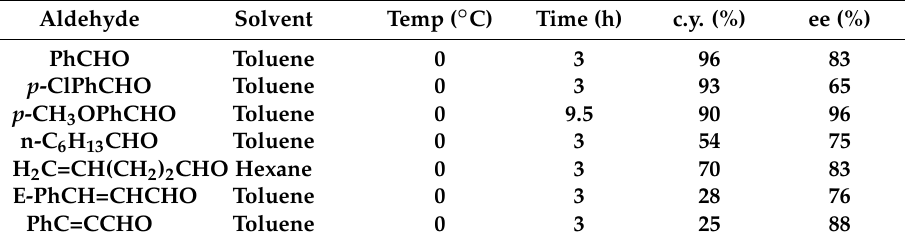
Table 6. Enantioselective addition of diethylzinc to aldehydes using 5 mol% of 48 [82].